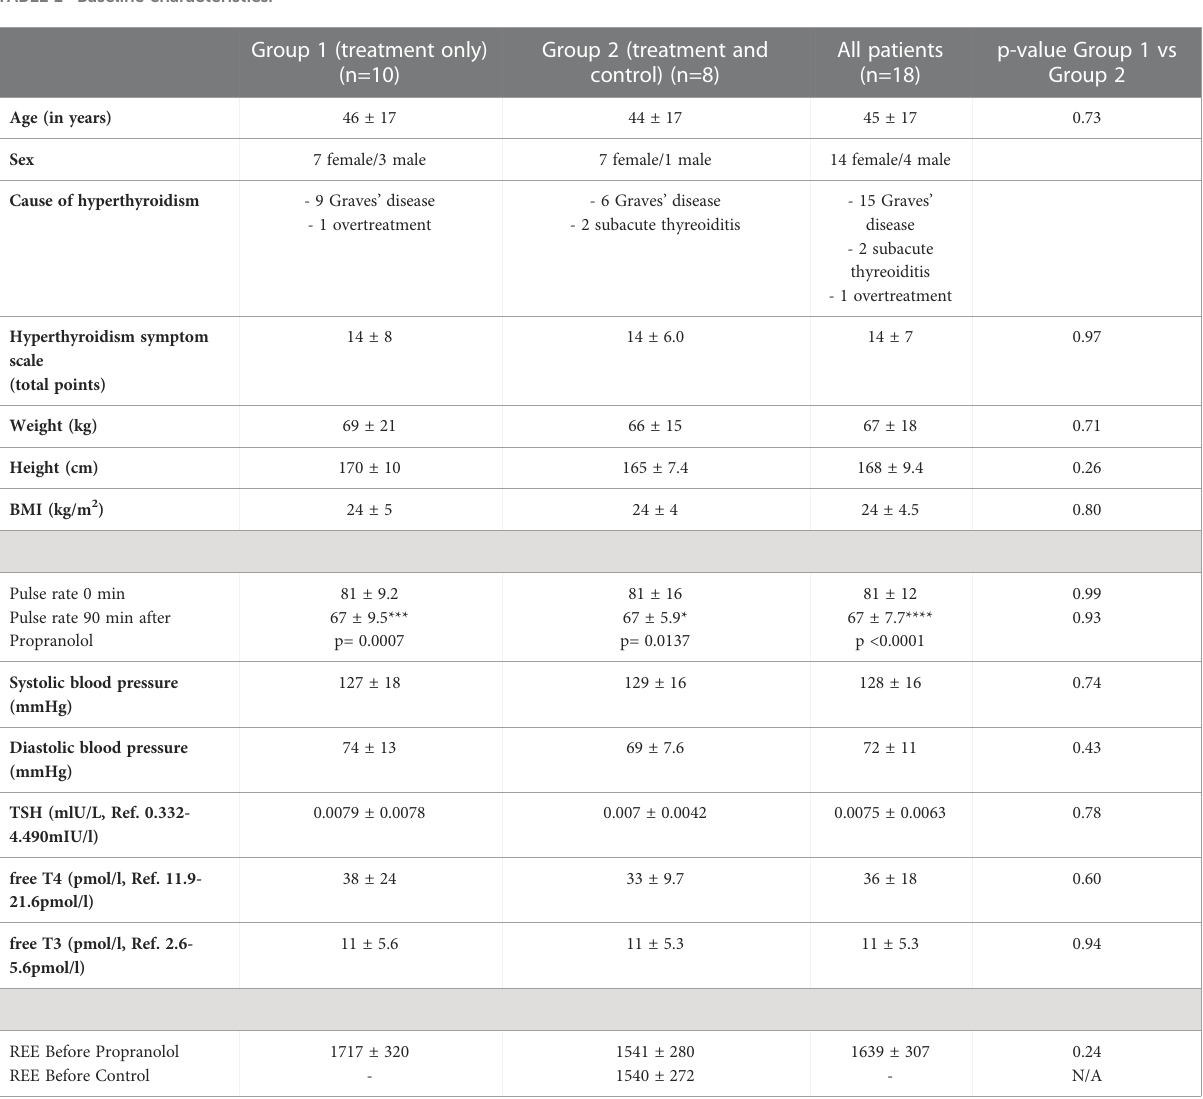
TABLE 1 Baseline